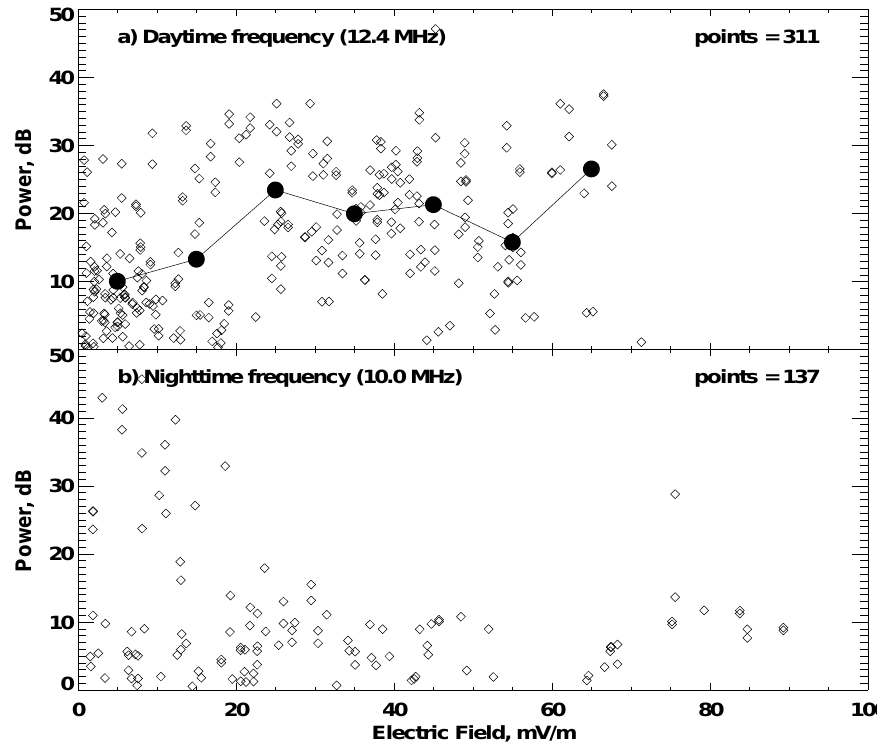
Fig. 8. Scatter plot of echo power versus electric field magnitude for all echoes observed over 4 days (a) for daytime observations at 12.4MHz (311 points) and (b) for nighttime observations at 10.0MHz (137 points). Shaded circles in (a) indicate the average power in the associated 10mV/m electric field